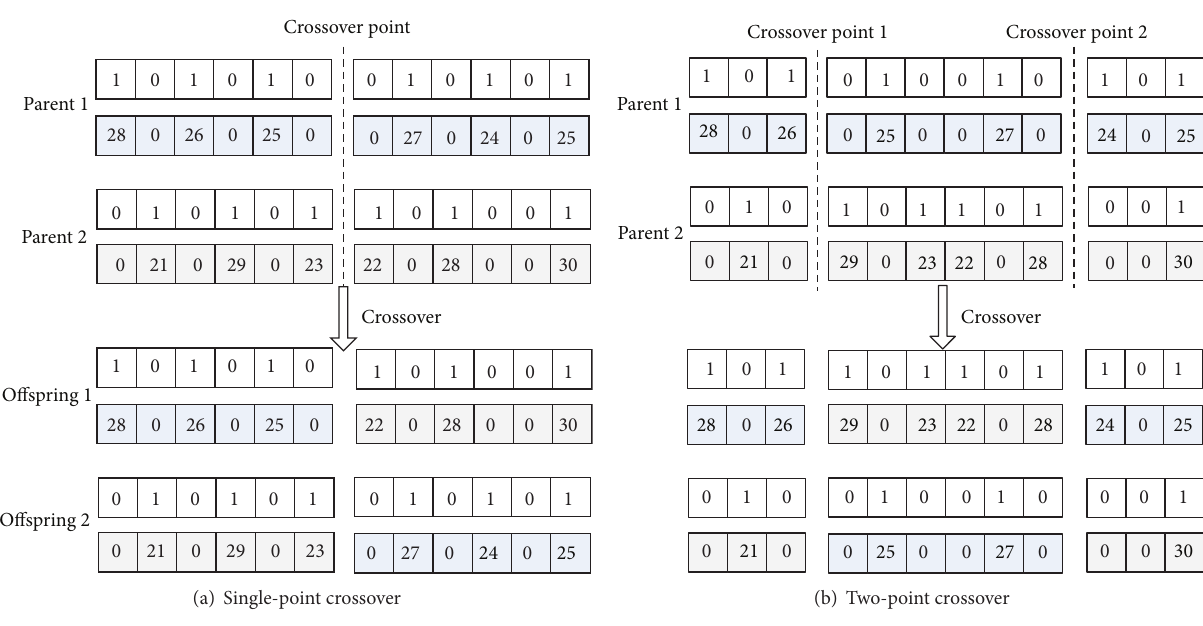
Figure 4: Illustration of crossover